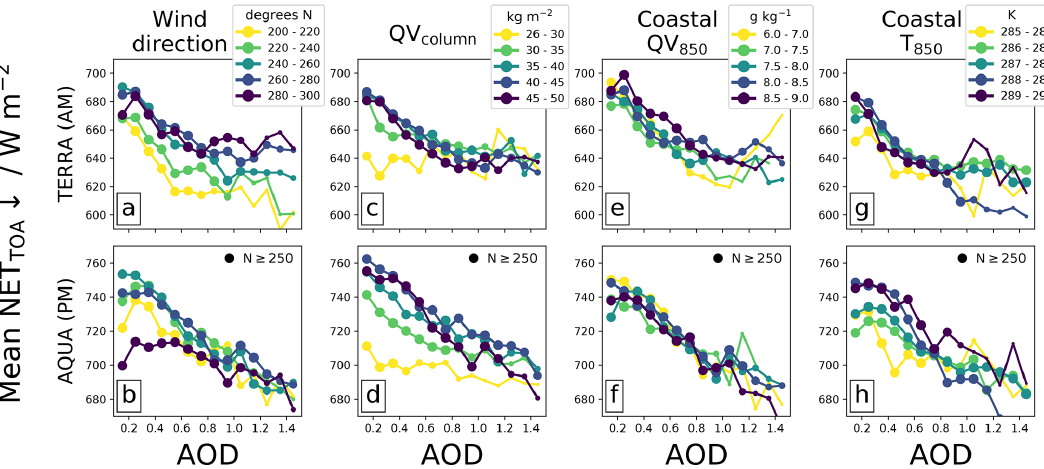
Figure 13. Mean NET TOA as a function of AOD subset by wind direction from due north (a–b) , where 270 ◦ describes an easterly; total column water vapour (c–d) ; mean water vapour content of the coastal boundary layer (e–f) ; and mean temperature of the coastal boundary layer (g–h) . The top row is for the TERRA overpass, and the bottom row is for the AQUA overpass. The size of each circle gives a representation of how many scenes are included in the mean, with a maximum size shown for N ≥